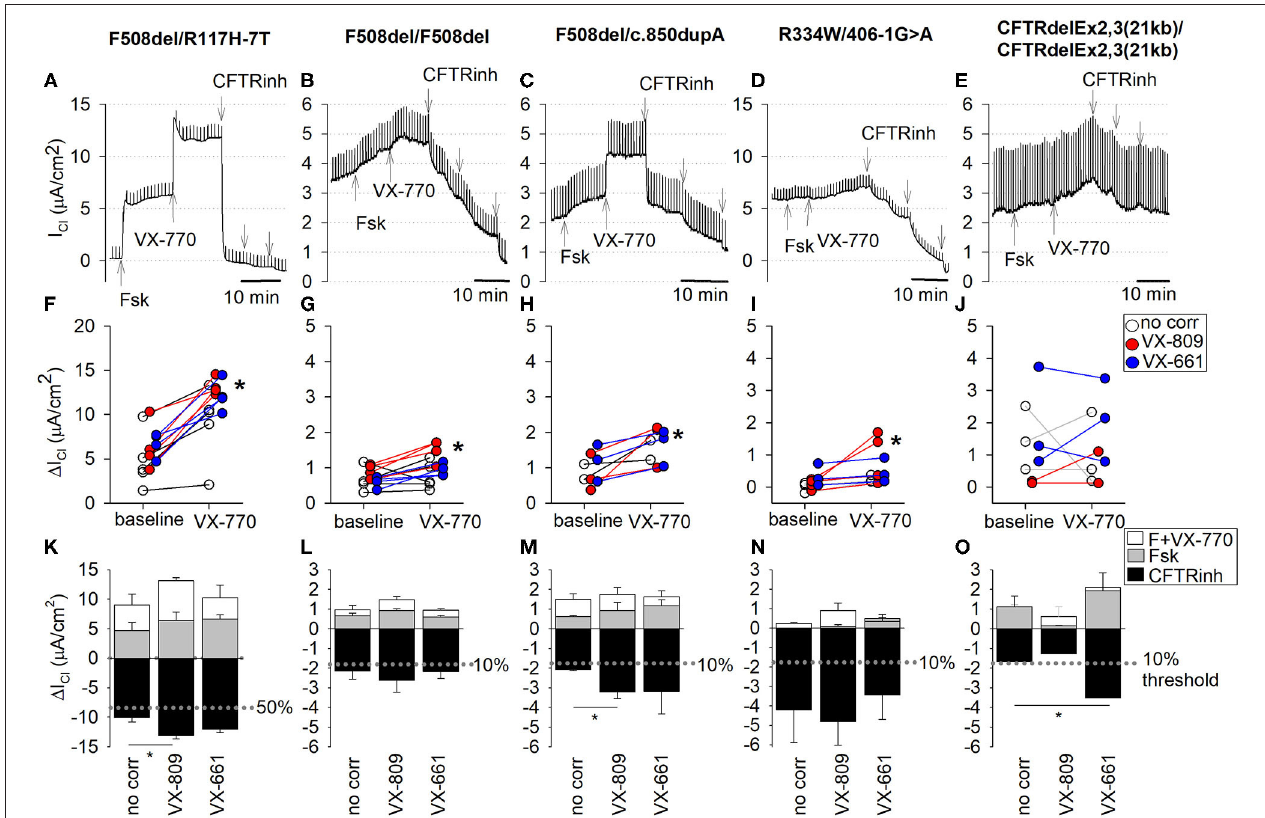
FIGURE 5 | CFTR function measurements in EpiX TM -expanded CF patient cultures. CF nasal epithelial cultures, five CF subjects with different genotypes. (A–E) Top. Detailed recordings of CFTR currents. Traces were from cultures treated with CFTR corrector VX-809. Chloride currents (I Cl ) were recorded in presence of amiloride. Note differences in scale, reflective of decreasing CFTR function with CF genotypes. CFTRinh refers to sequential addition of three CFTR inhibitor compounds (CFTRinh-172, PPQ-102, and GlyH-101). Middle (F–J) : Individual responses to forskolin (baseline) and forskolin plus VX-770 (VX-770). Baseline represents change in cAMP-dependent CFTR current by forskolin alone. VX-770 represents change in current by forskolin + VX-770. *denotes significant increase by VX-770 (paired t -test, p < 0.05). Bottom (K–O) : Average stimulated and blocked CFTR currents of non-treated cultures (no corr) and cultures treated with CFTR corrector VX-809 or VX-661. Upward bars present chloride current change ( 1 I Cl ) after stimulation with forskolin alone (cAMP; gray) or after stimulation with forskolin plus VX-770 (white, VX-770). Downward bars present 1 I Cl after maximal block by CFTR inhibitors (CFTRinh; black). Bars represent mean ± SE. *, significantly different by unpaired t -test ( p < 0.05). (A,F,K) F508del/R117H-7T, passage 3 (PD = 8.7). Non-treated: n = 5; VX-809 treated: n = 4; VX-661 treated: n = 4. (B,G,L) R334W/406-1G > A, passage 3 (PD = 8.7). Non-treated: n = 3; VX-809 treated: n = 4; VX-661 treated: n = 3. (C,H,M) F508del/c.850dupA, passage 4 (PD = 11.6). Non-treated: n = 2; VX-809 treated: n = 3; VX-661 treated: n = 3. (D,I,N) F508del homozygote, passage 3 (PD = 10.4). Non-treated: n = 5; VX-809 treated: n = 4; VX-661 treated: n = 4. (E,J,O) CFTRdele2,3(21kb) homozygote, passage 3 (PD = 10.4). Non-treated: n = 4; VX-809 treated: n = 2; VX-661 treated: n =